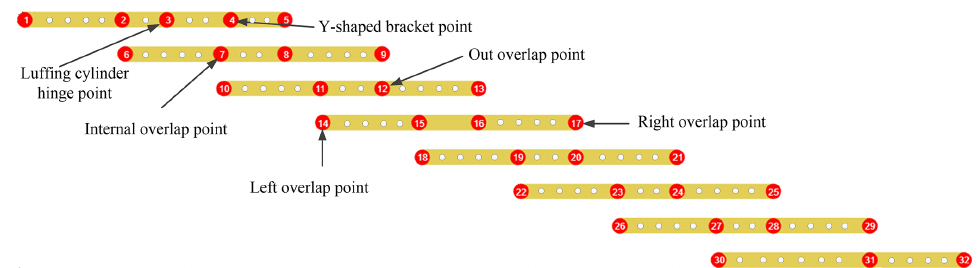
Figure 2. Substructures of a telescopic boom.